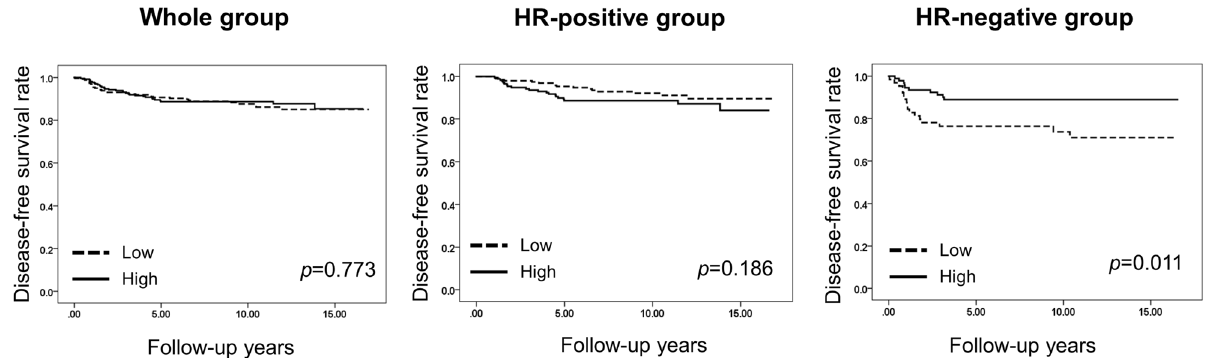
Figure 2. Kaplan–Meier survival curves according to the expression level of human leukocyte antigen (HLA) class I in patients with invasive breast carcinoma. Low HLA class I expression is associated with shorter disease- free survival of patients in the hormone receptor (HR)-negative subgroup. There is no survival difference in the whole group and in the HR-positive